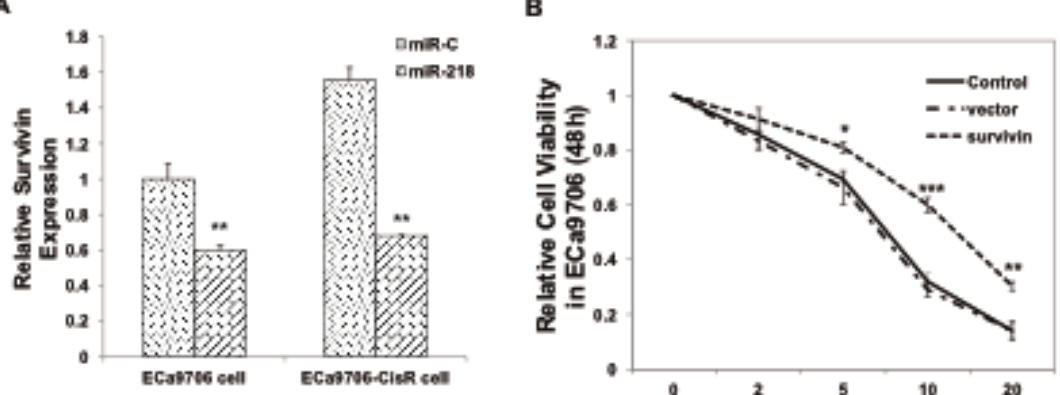
Figure 3. miR-218 downregulates survivin to increase cisplatin sensitivity in both Eca9706 and Eca9706-CisR cells. (A) Either control microRNA or miR-218 mimics were transfected into both ECa9706 and ECa9706-CisR cells. 48h later, cells were harvested for qRT-PCR test. **: P<0.01. (B) Survivin was overexpressed in Eca9706 cells by plasmid transfection. Then cells were treated with increasing doses of cispla- tin (0, 2, 5, 10 and 20 m M). 24h later, MTT assay was performed. *: P<0.05, **: P<0.01, ***: